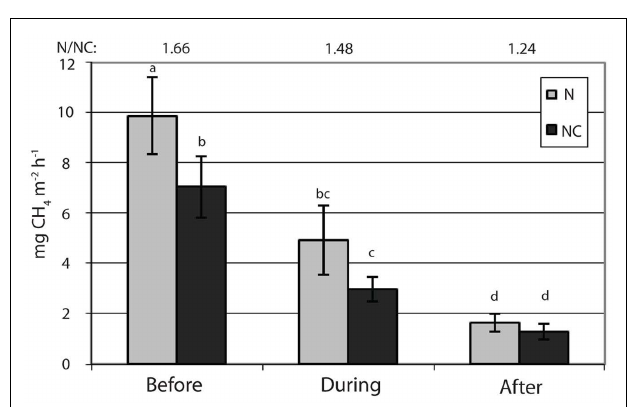
FIGURE 2 | Methane fluxes. N denotes nitrogen loading plots and NC control plots. Fixed effect of nitrogen load: F = 2.3, P = 0.204. Significant differences in fluxes are marked with letters ( P < 0.05).The ratio of methane fluxes in the nitrogen loaded plots to those in the control plots are shown by numbers on top of the